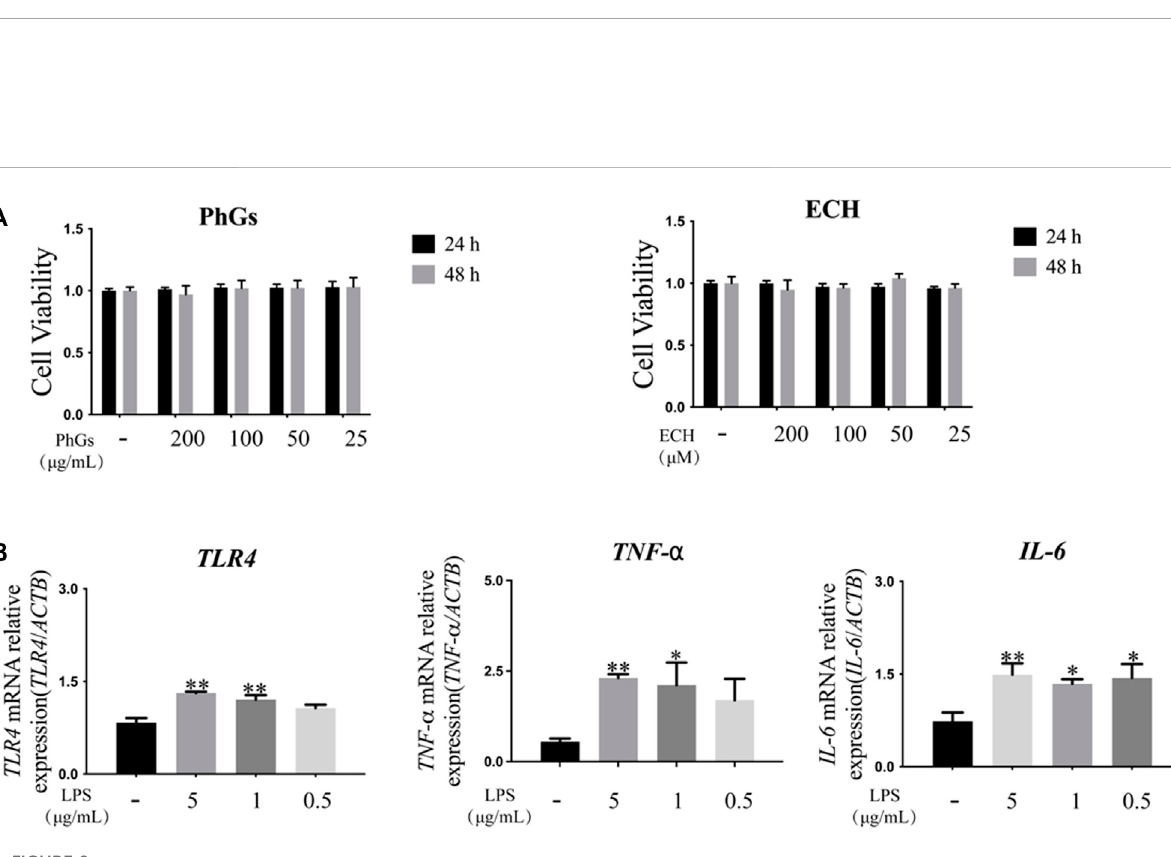
FIGURE 9 Establishmentofthein fl ammationmodelinL02cells. (A) CellviabilityofL02wasaffectedbydifferentdosesanddurationofactionofPhGsand ECH ( n > 3). (B) Expression of TLR4 , IL-6 , and TNF- α genes in L02 cells cultured with different concentrations of LPS ( n = 3). * p < 0.05 and ** p < 0.01 control group compared with the LPS group; all data are presented as mean ±